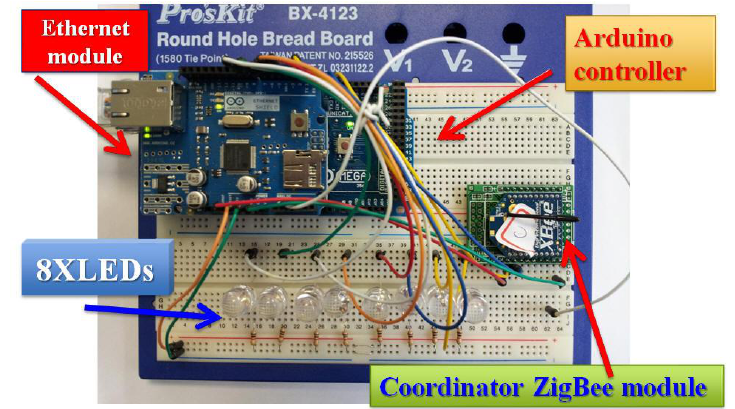
Figure 39. Introduction to the receiver side of our ZigBee